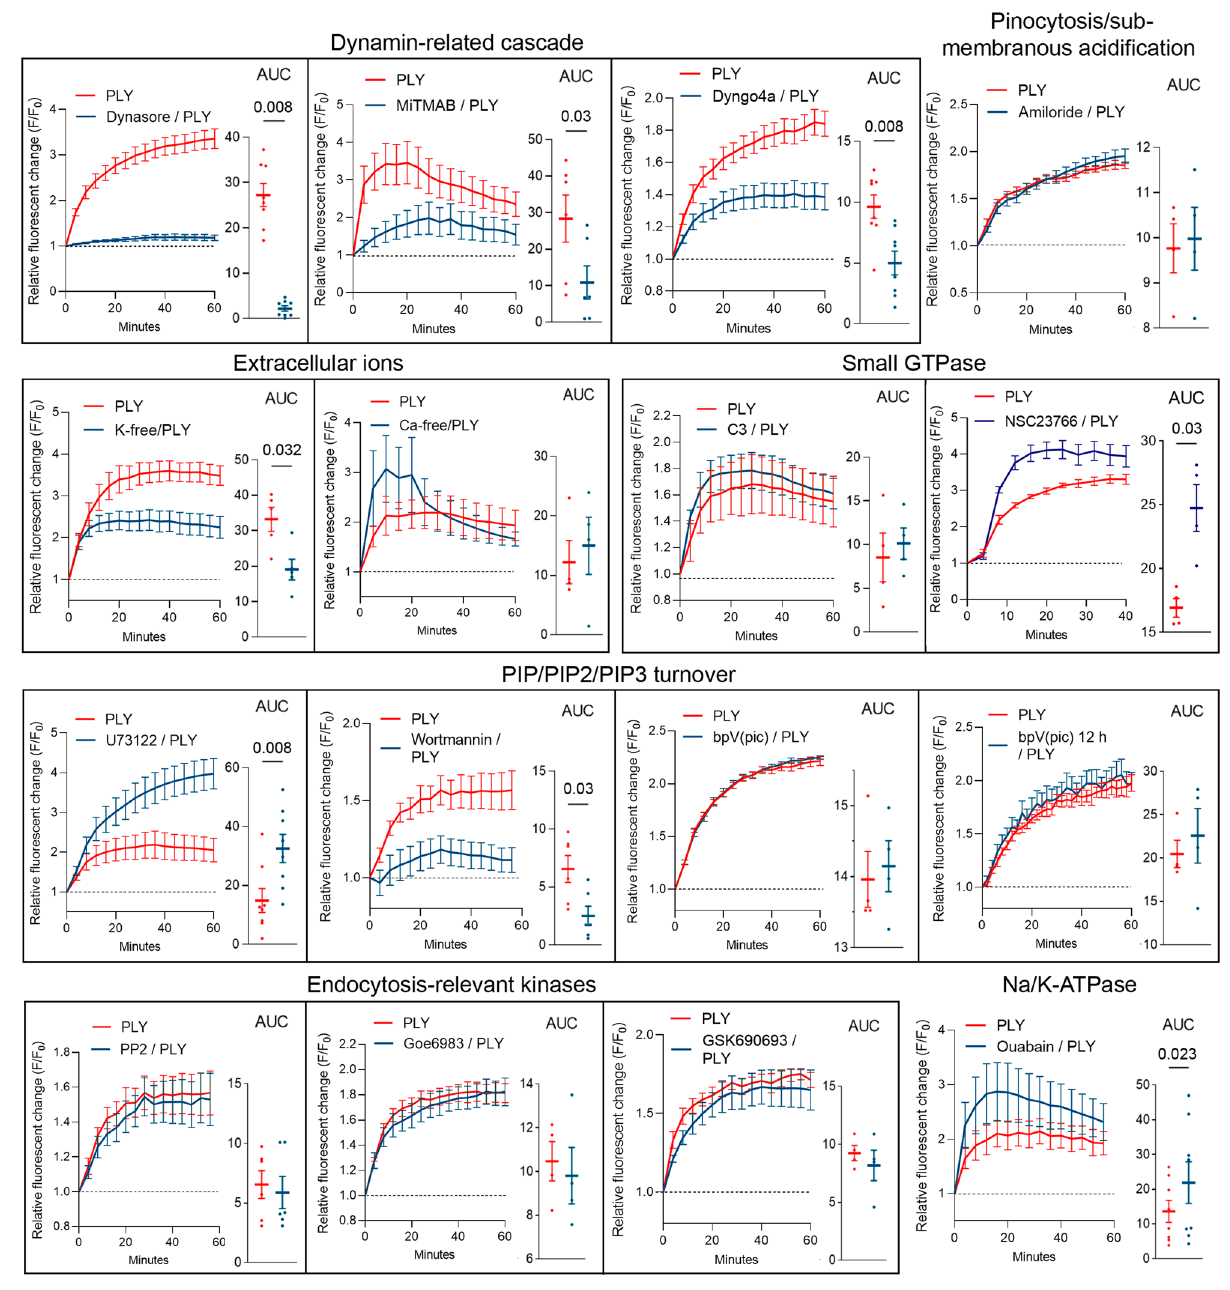
Fig. 6 | Molecular mechanism of enhanced endocytosis by recombinant PLY. Curves normalized fi rst to timepoint 0, followed by normalization to mock (vehi- cle)-treated or inhibitor-treated controls for PLY-relevant inhibitors/inhibitory conditions.Mixedgliawereincubatedwith2HU/mlPLYinthepresenceofavehicle or inhibitor, and the FM4-64 fl uorescence change was recorded. The concentra- tions used are listed in the Materials and Methods and in Table 1. Abbreviations (if notself-explanatory)areC3-C3transferase,RhoAGTPaseinhibitor;NSC23766-Rac1 GTPase inhibitor; U73122-phospholipase C inhibitor; Wortmannin-PI3K inhibitor; bpV(pic)-PTENinhibitor(lastthreeareenzymesinvolvedinthemetabolismofPIP2 andPIP3);PP2-broad-spectrumSrc-kinaseinhibitor;Goe6983-broad-spectrumPKC inhibitor; GSK690693-Akt-kinase and PKC-epsilon inhibitor; ouabain-Na/K-ATPase blocker. Endocytosis by PLY is inhibited by dynamin GTPase inhibitors, potassium depletion and PI3K inhibitors; it isenhanced by PLCinhibition, Rac1 inhibition and